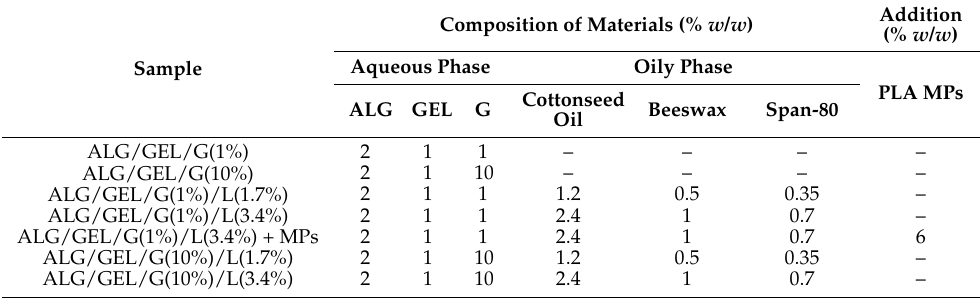
Table 1. The types of prepared materials composed of sodium alginate (ALG), gelatin (GEL), glycerol (G) and different amount of lipids (L): cottonseed oil, beeswax and emulsifier Span-80, as well as the sample containing polylactide microparticles (PLA MPs). Data from